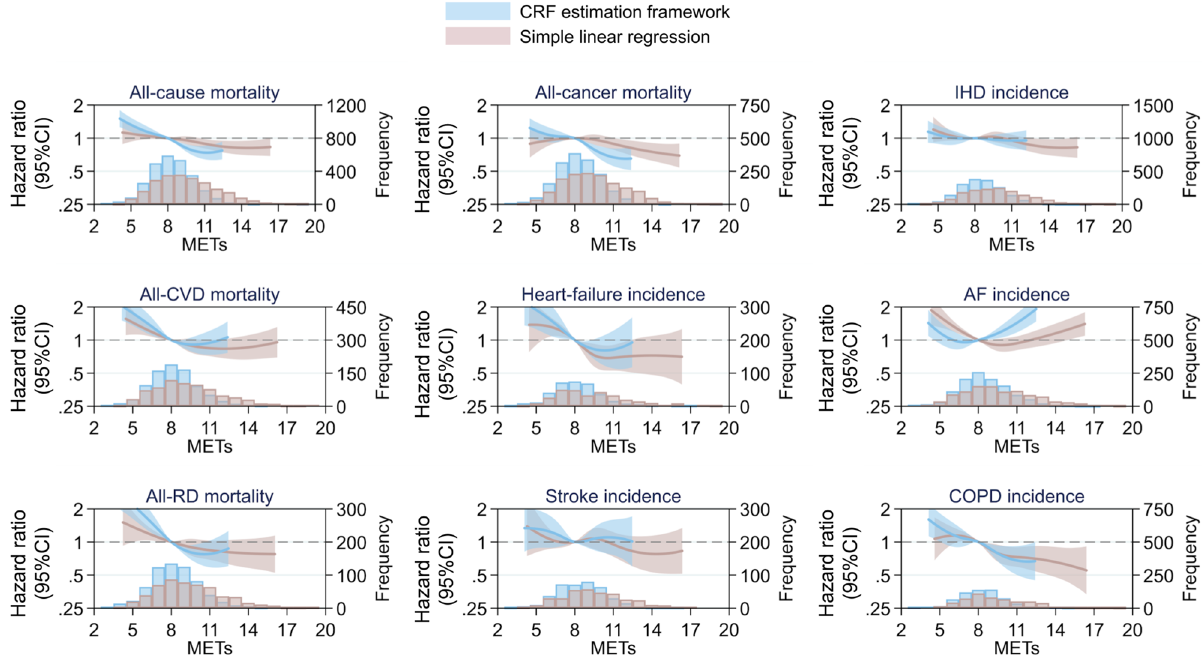
Figure 6. Hazard ratio and 95% confidence interval (CI) for nonlinear associations (cubic splines, Cox regression) between fatal and non-fatal outcomes in the UK Biobank with cardiorespiratory fitness in metabolic equivalents (METs, per 3.5 ml O 2 ·kg −1 ·min −1 ) computed from the multilevel framework and simple linear regression methods. Hazard ratios were computed relative to a fitness reference point of 8.0 METs. AF: atrial fibrillation; COPD: chronic obstructive pulmonary disease; CVD: cardiovascular disease; IHD: ischaemic heart disease; RD: respiratory disease. Mortality and incidence counts (superimposed histograms) differ between fitness estimation methods owing to different inclusion criteria at the estimation